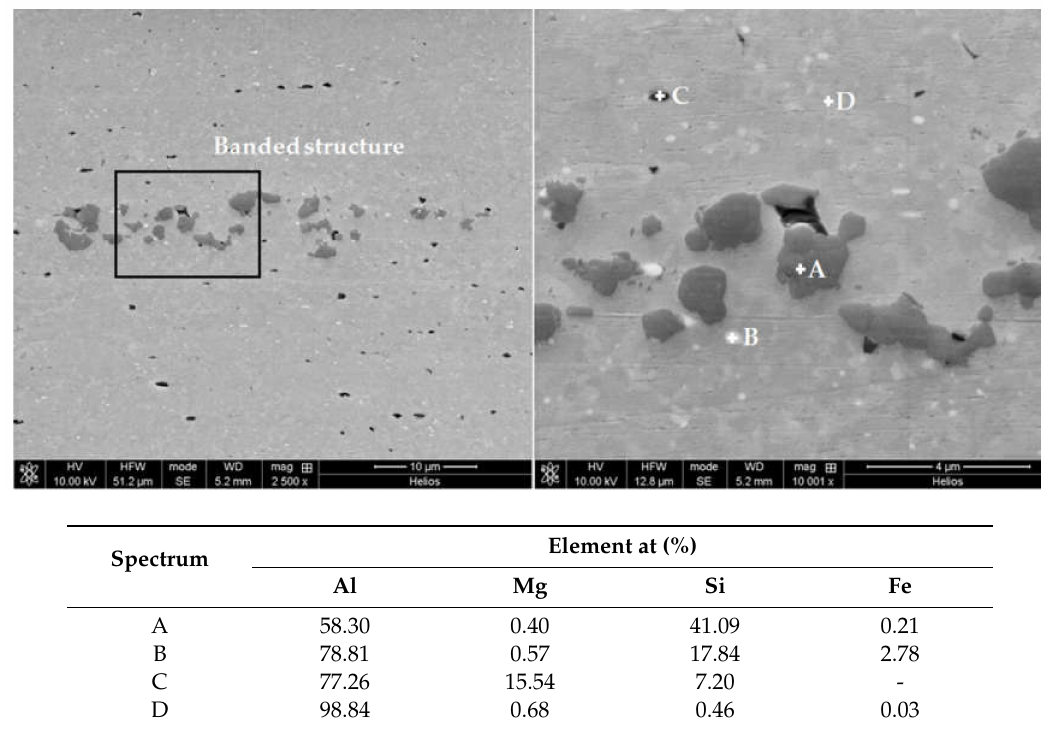
Figure 3. SEM micrographs and EDS analysis of the precipitates of different second phases present in the profiles extruded from AA 6005A powders.